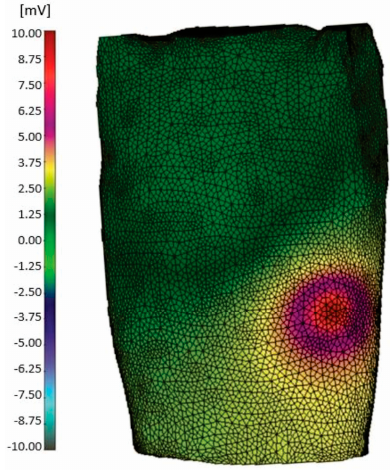
Figure 3. FEM simulation: body surface potential